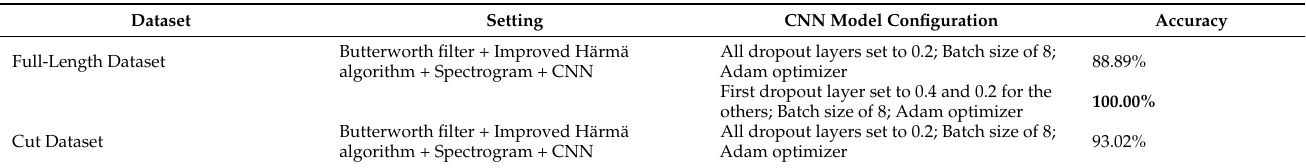
Table 4. Experimental results using the improved Härmä